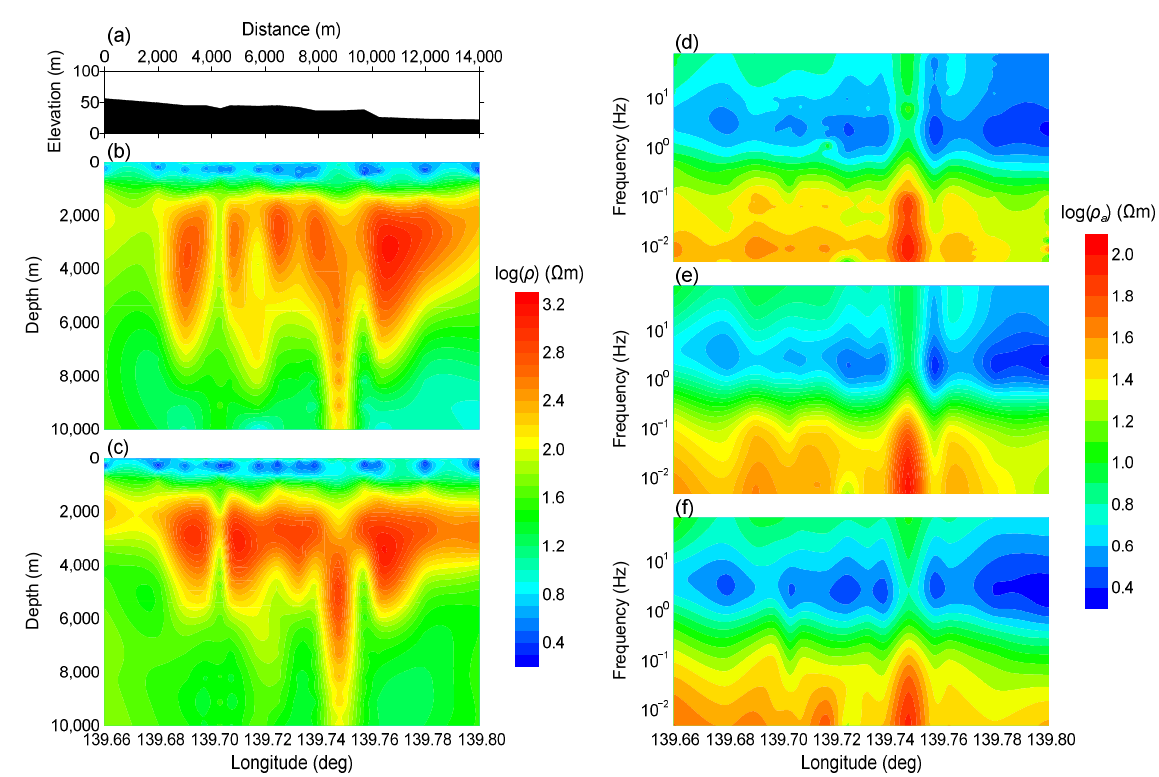
Figure 18. The inversion results and the corresponding MT responses of filed data. ( a ) shows the elevation section along the survey profile. ( b , c ) are the pseudo cross-sections of the inverted resistivity models recovered by the Occam and PhyDNN methods, respectively. ( d – f ) show the real responses and the corresponding simulated responses (only the apparent resistivity is shown here) of the inversion results for the Occam and PhyDNN methods separately.